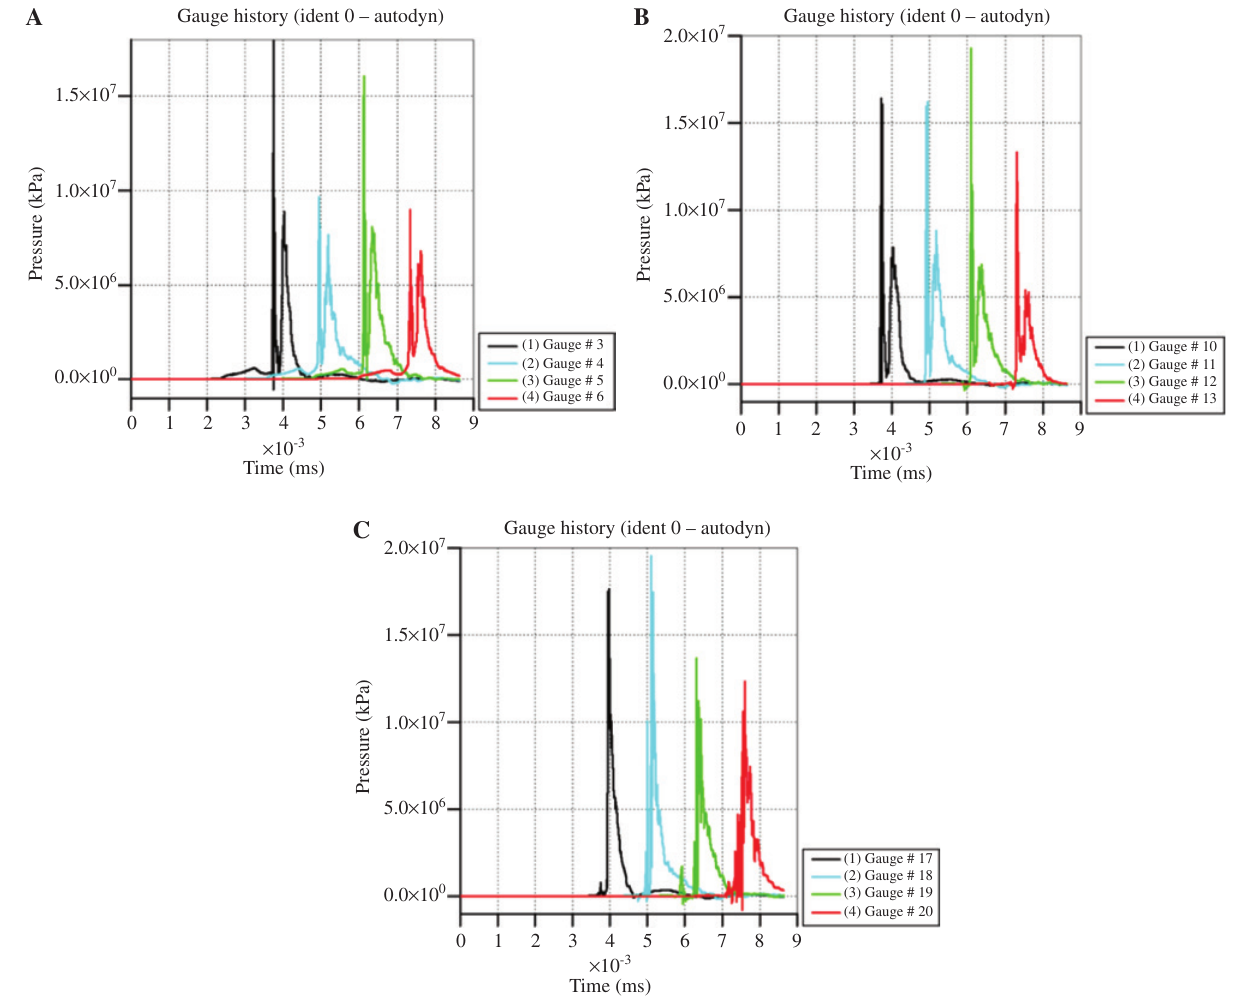
Figure 10: Pressure-time curve along the direction of propagation of detonation: (A) the upper surface of aluminum alloy plate; (B) the lower surface of aluminum alloy plate; (C) the upper surface of the magnesium alloy